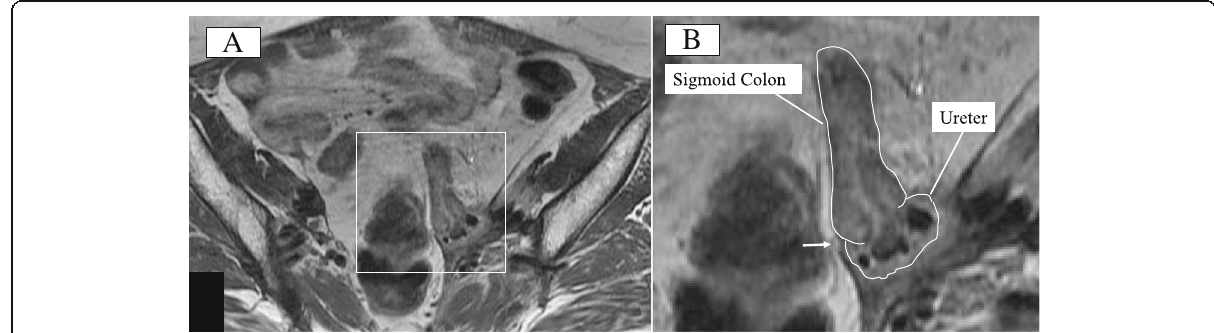
Fig. 2 Magnetic resonance imaging revealed a fistula formation (arrow) between the sigmoid colon and ureter ( a overall view and b enlarged